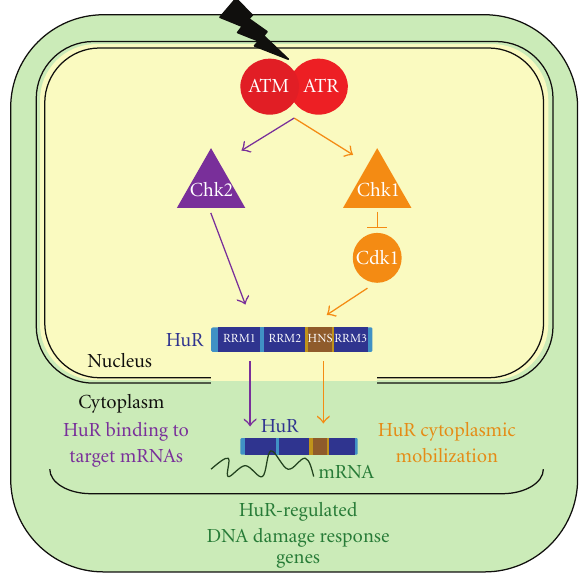
Figure 2: Regulation of HuR function by ATM/ATR → Chk1/Chk2. ATM/ATR regulates HuR function through the acti- vation of Chk1 and Chk2. Active Chk1 phosphorylates (and hence inactivates) Cdk1, a kinase that phosphorylates HuR at S202; in turn, unphosphorylated HuR(S202) can be transported to the cytoplasm (orange). Active Chk2 phosphorylates HuR at S88, S100, and T118 (at RRM1 and RRM2); in turn, HuR association with target mRNAs is altered (purple). Jointly, ATM/ATR → Chk1/Chk2 modulates the amount of HuR in the cytoplasm and its interaction with target mRNAs